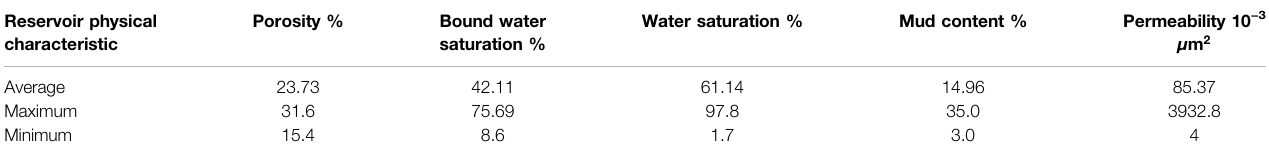
TABLE 1 | Reservoir physical properties in the study area.